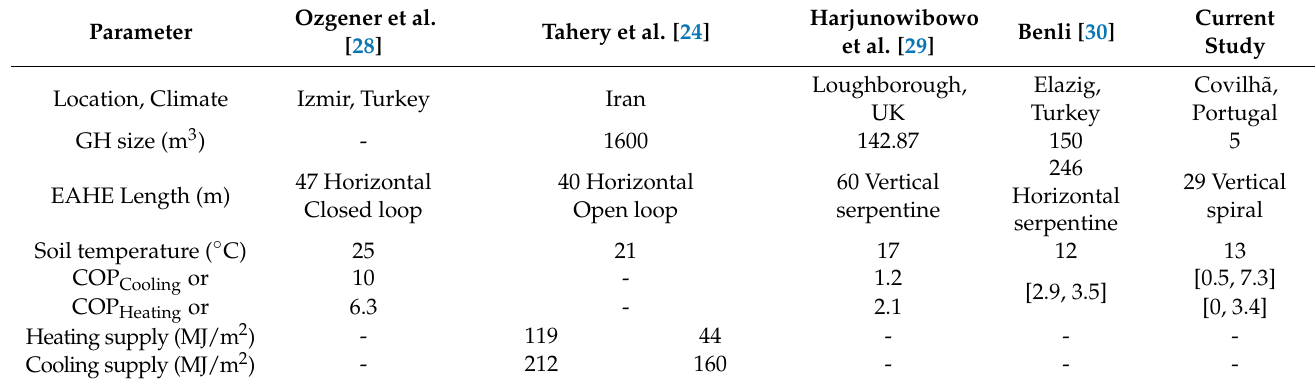
Table 5. Parameter from